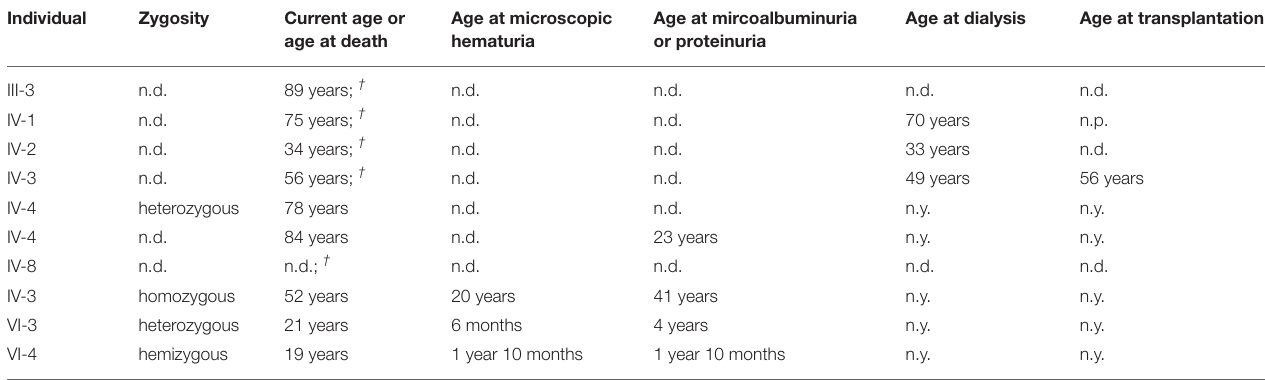
TABLE 1 | Overview about the p.(Gly624Asp) in COL4A5 -associated clinical phenotype and the genetic zygosity of the affected family members.